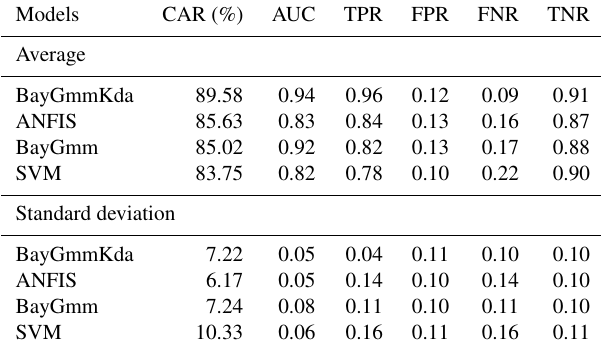
Table 3. Performance comparison of the BayGmmKda model with the three benchmarks, the SVM model, the ANFIS model, and the BayGmm model.